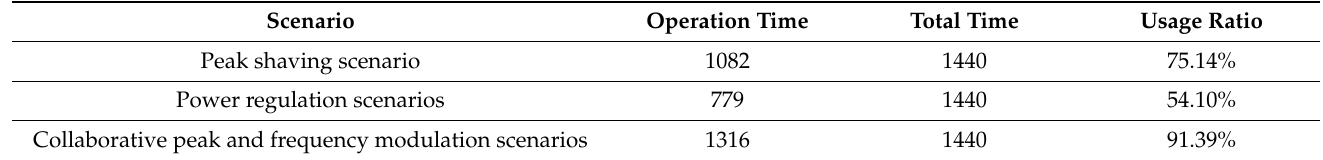
Table 8. Energy storage utilization results for each scenario.